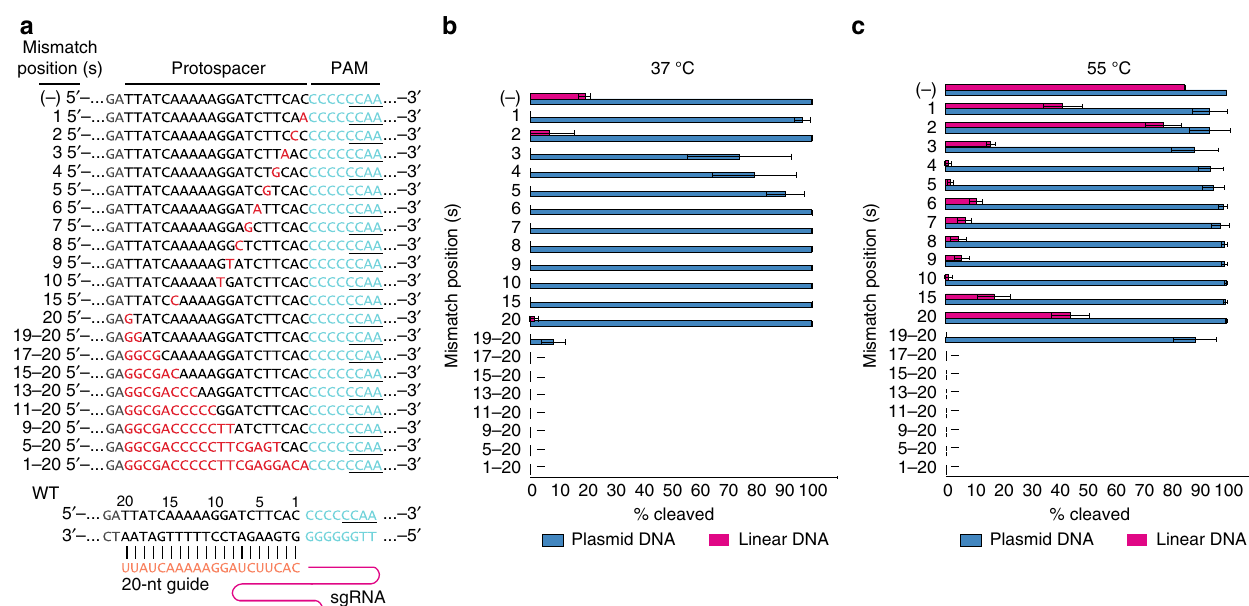
Fig. 4 Protospacer targeting Speci fi city of ThermoCas9. a Scheme of the generated mismatch protospacers library, employed for evaluating the ThermoCas9:sgRNA targeting speci fi city in vitro. The mismatch spacer-protospacer positions are shown in red, the PAM in light blue with the fi fth to eighth positions underlined. b Graphical representation of the ThermoCas9:sgRNA cleavage ef fi ciency over linear or plasmid targets with different mismatches at 37 °C. The percentage of cleavage was calculated based on integrated band intensities after gel electrophoresis. Average values from three biological replicates are shown, with error bars representing S.D. The blots of one of the replicates are shown in Supplementary Fig. 12. c Graphical representation of the ThermoCas9:sgRNA cleavage ef fi ciency over linear or plasmid targets with different mismatches at 55 °C. The percentage of cleavage was calculated based on integrated band intensities after gel electrophoresis. Average values from three biological replicates are shown, with error bars representing S.D. The blots of one of the replicates are shown in Supplementary Fig.